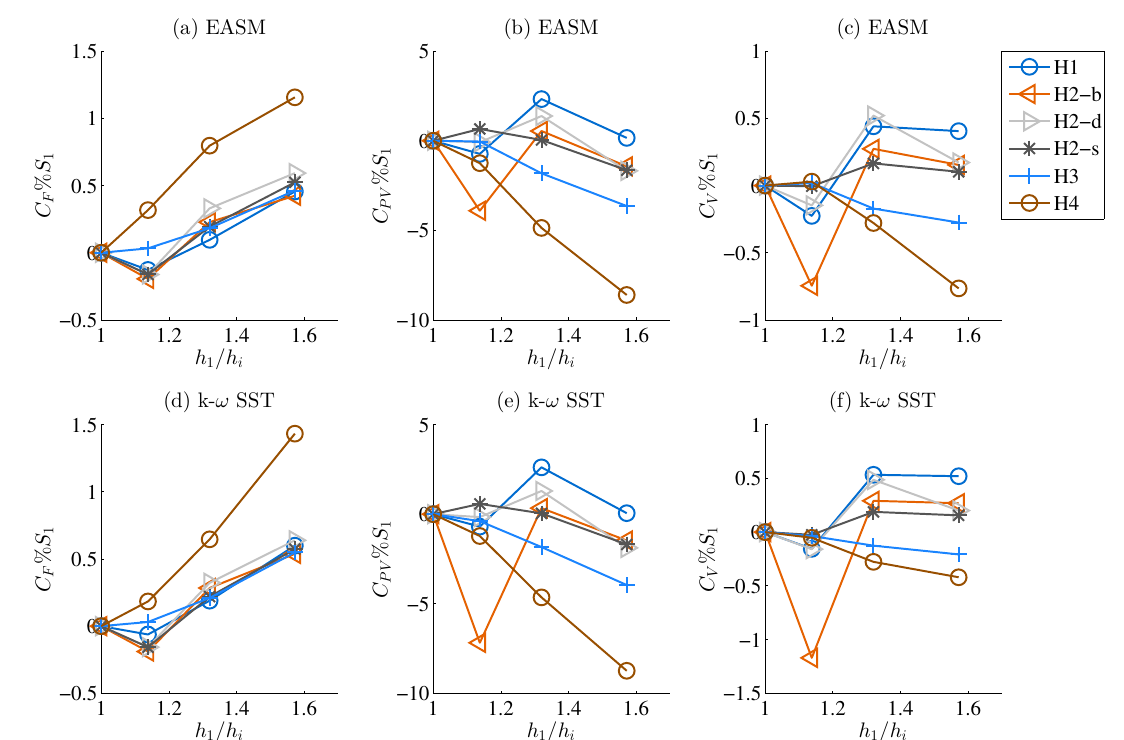
Figure 2. Computed values for ( a ) C F , ( b ) C PV and ( c ) C V with the EASM model and ( d ) C F , ( e ) C PV and ( f ) C V with the k − ω SST model vs. grid refinement ratio, h 1 / h i = 3